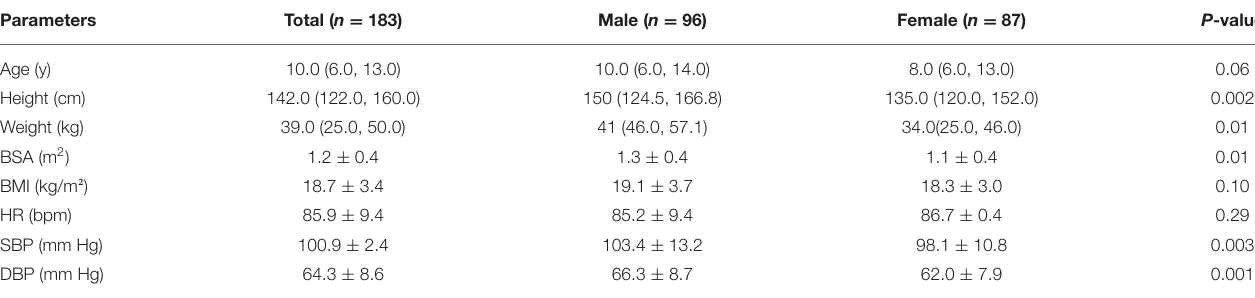
TABLE 1 | Baseline characteristics of the population. Parameters